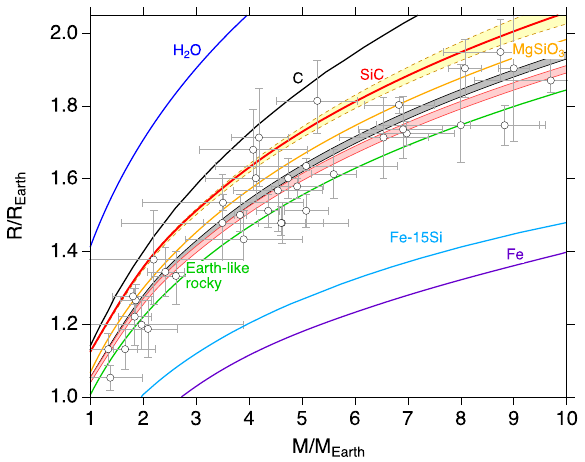
Fig. 7 Calculated mass-radius relationships compared with observed exoplanets. Mass-radius curves are shown for hypothetical planets composed entirely of SiC (this study), diamond 26 , H 2 O 50 , MgSiO 3 50 , Fe- 15Si 23 , and Fe 72 . The mass-radius relationship for an Earth-like rocky planet is shown in green. The yellow band represents the mass-radius relationship for a SiC planet using the B1 SiC equation of state from previous studies 18,20,26 – 33 . The pink band shows the predicted mass-radius relationship for a planet consisting of pure SiC mantle and a Fe or Fe-15Si core (mass fraction of core assumed to be 30%). The gray band shows the mass-radius relationship for a planet with 50% SiC-50% diamond mantle and a Fe or Fe-15Si core (mass fraction of core assumed to be 30%). Observed exoplanets are shown as gray circles with error bars (http:// exoplanetarchive.ipac.caltech.edu). R E and M E are the radius and mass of Earth,